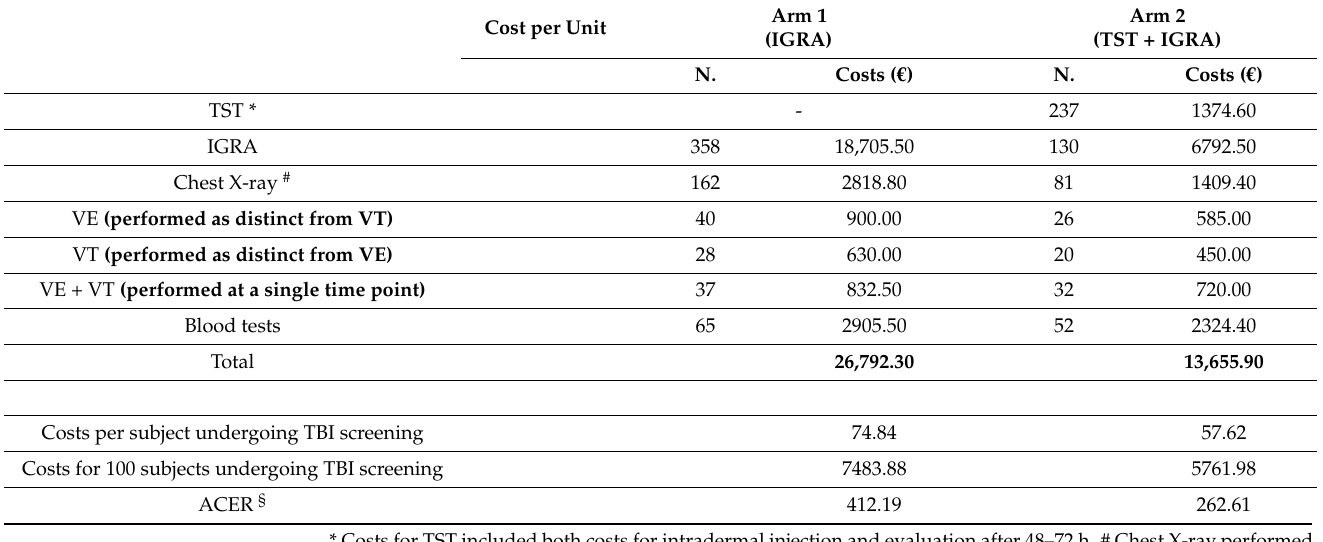
Table 4. Costs and cost-effectiveness analysis for two screening strategies: IGRA only (arm 1) and sequential screening with TST followed by IGRA (arm